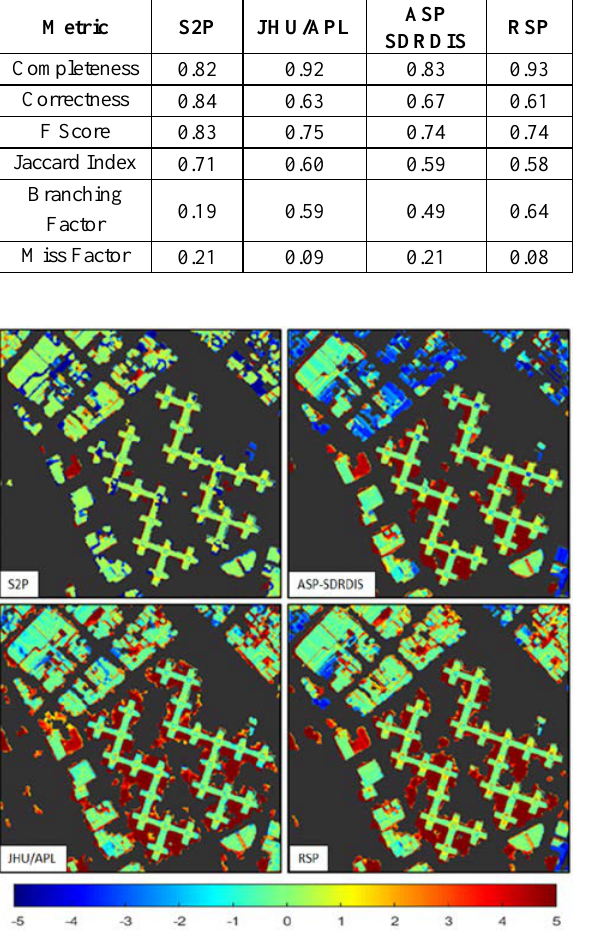
Table 5 3D building volumetric accuracy for MVS solutions